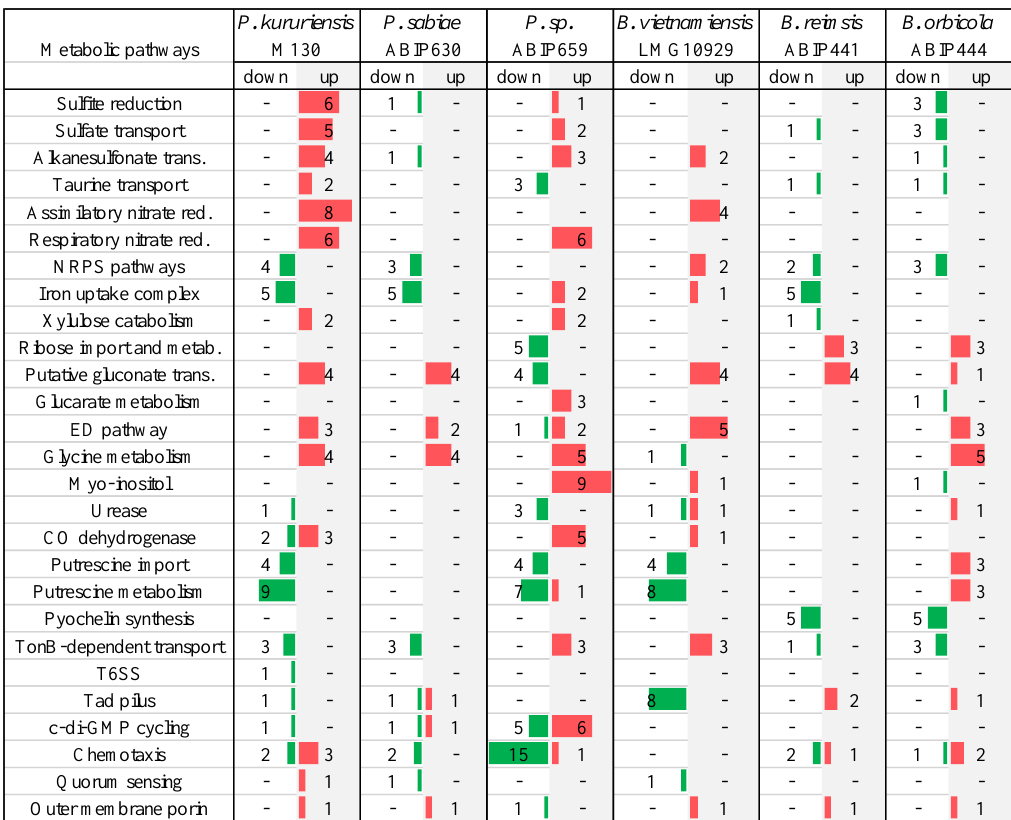
Table 2 - Differentially regulated gene categories in the six Burkholderia s.l.